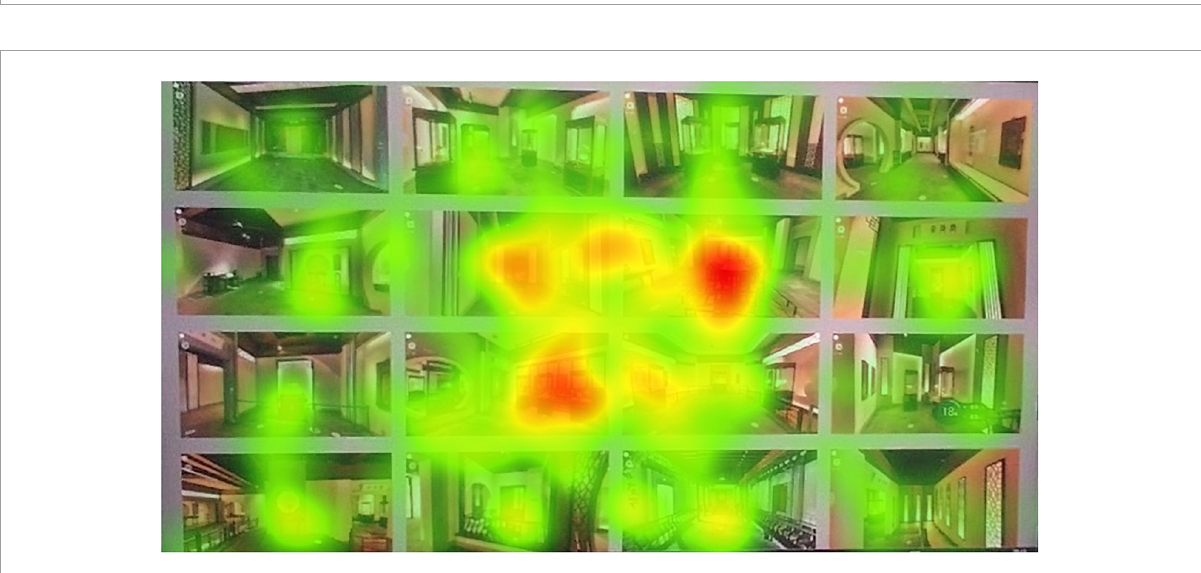
FIGURE7 Total heat map of subject’s